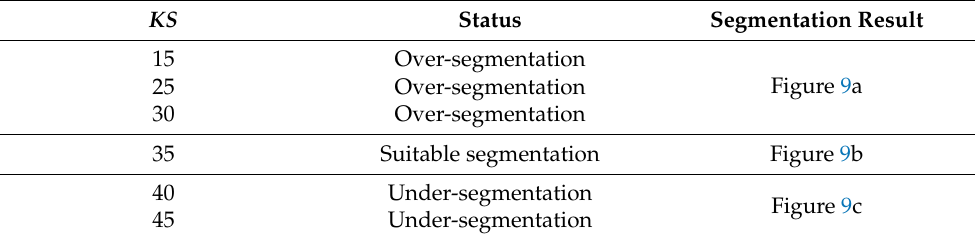
Table 5. Segmentation results of different KS